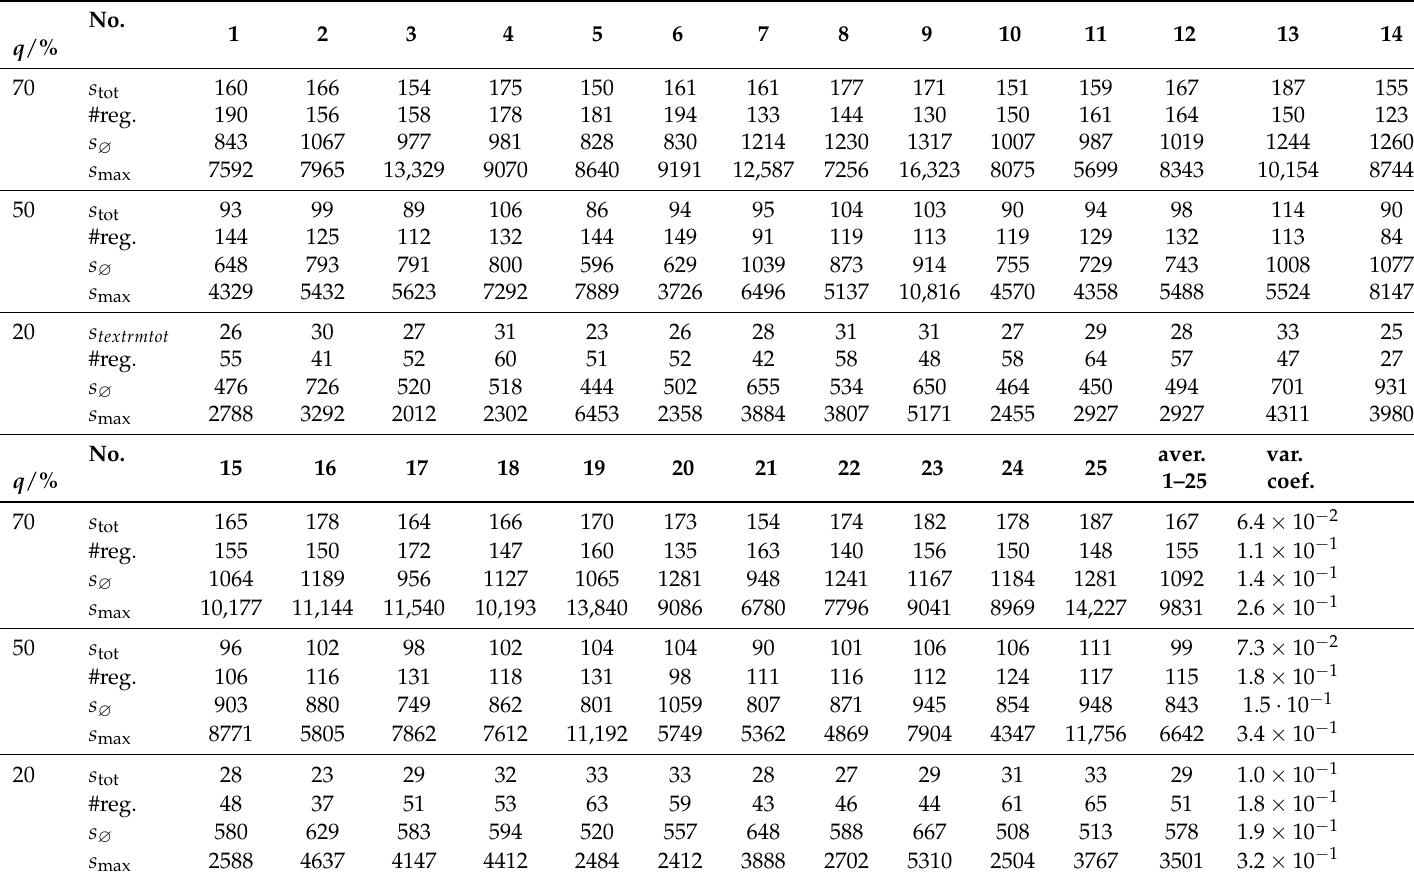
Table 2. Analysis of the GDL/channel interface, uncompressed. s tot in 1000 µm 2 . s ∅ , s max in µm 2 . Total surface: 590,000 µm 2